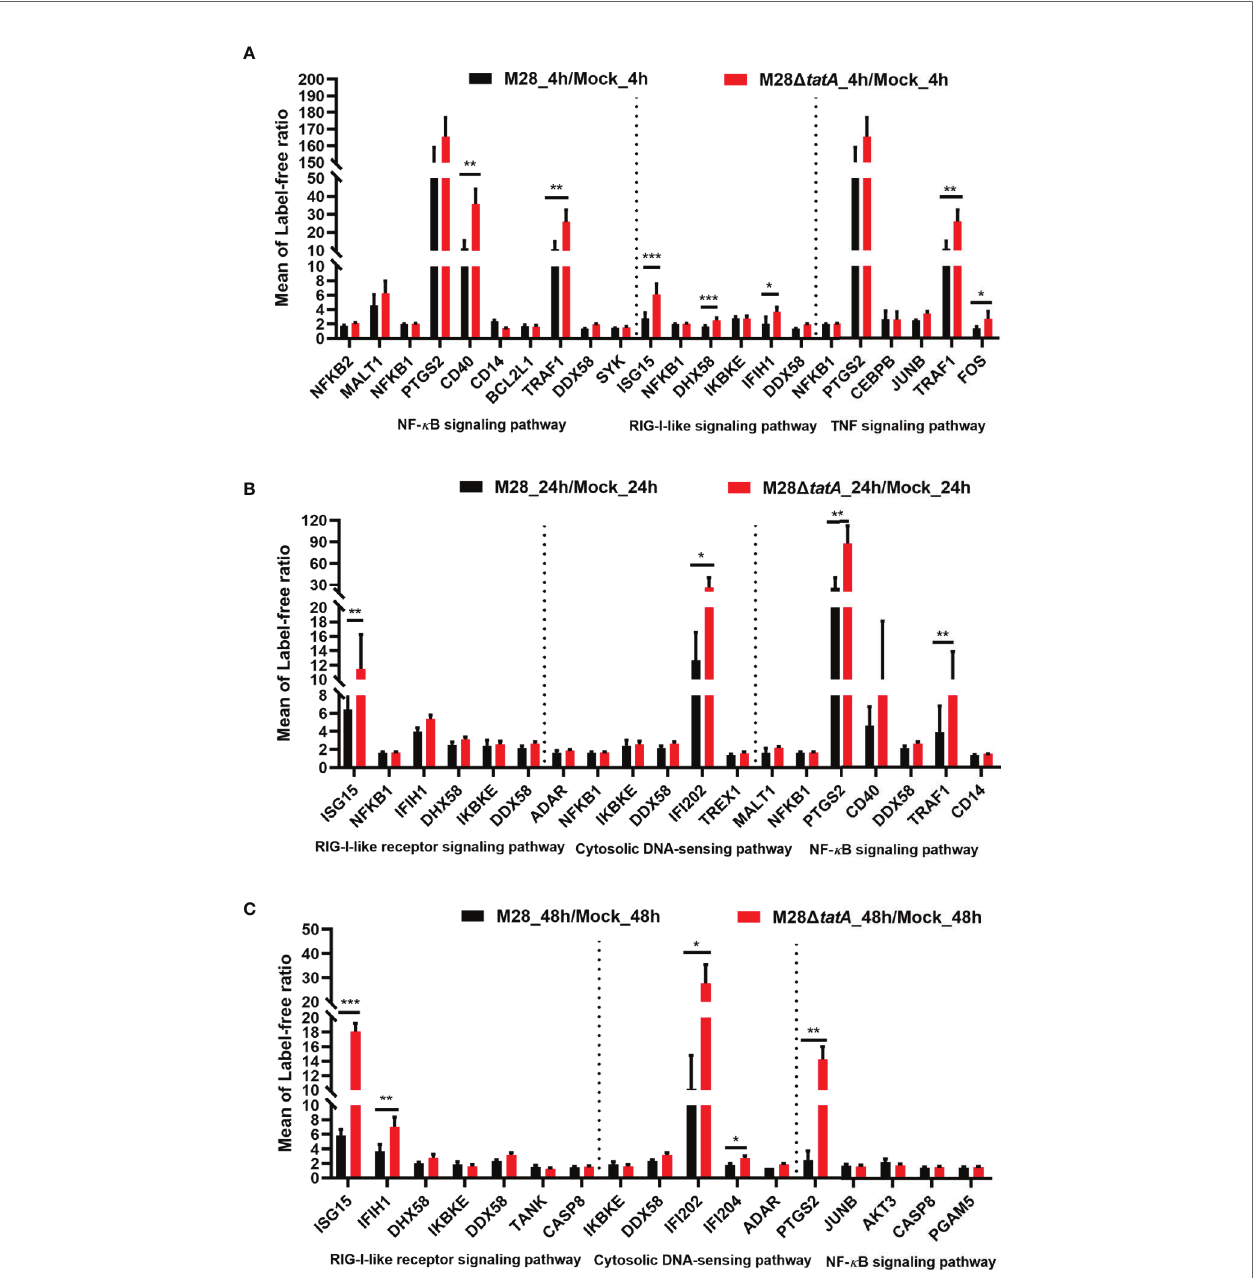
FIGURE 4 | Regulation of proteins involved in key in fl ammatory pathways in RAW264.7 cells after infection with M28 and M28 D tatA at 4 hpi (A) , 24 hpi (B) and 48 hpi (C) . Student ’ s t test was used to evaluate signi fi cant differences between the M28 D tatA mutant and the wild type. *p < 0.05; **p < 0.01; ***p <